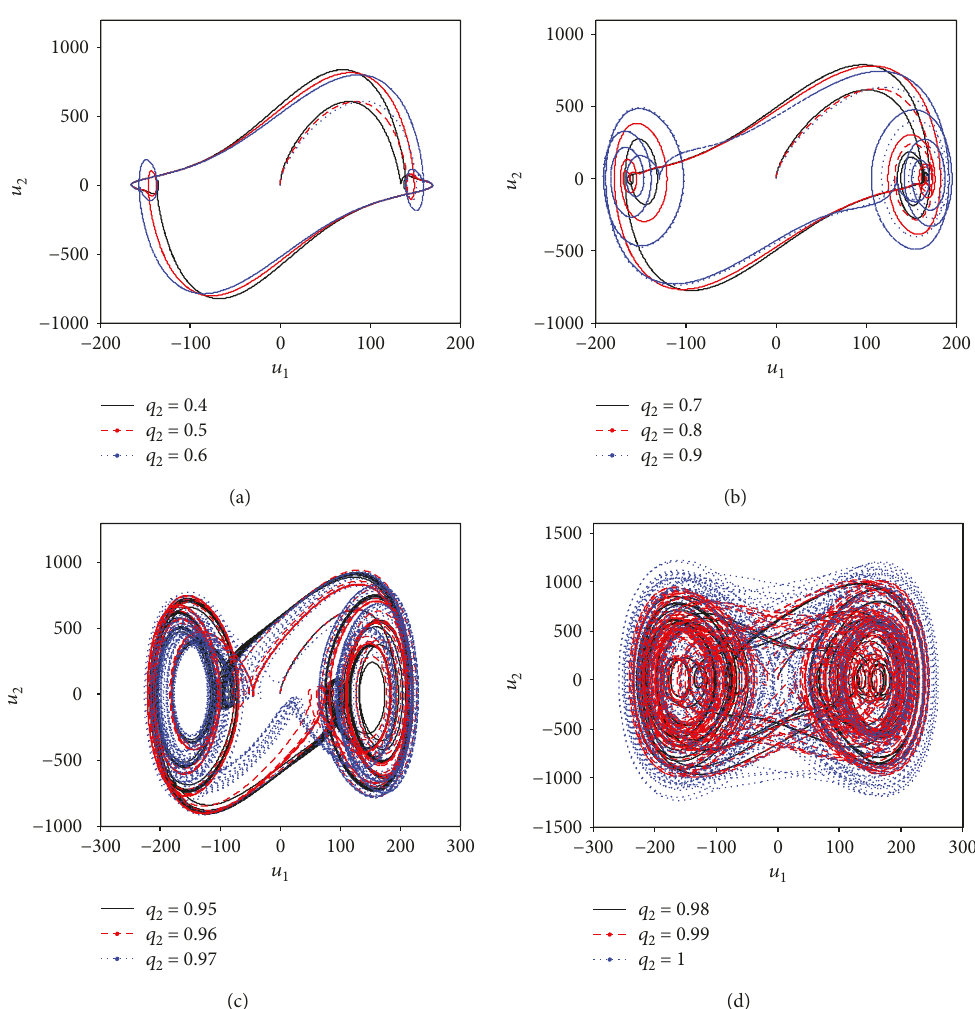
= 0 4 , q = 0 5 , and q = 0 6 . (b) Phase portrait for q 2 2 2